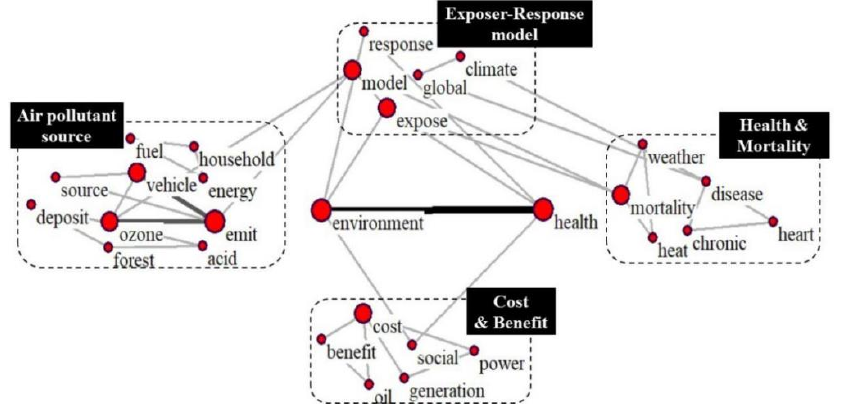
Figure 7. Group I research topics .